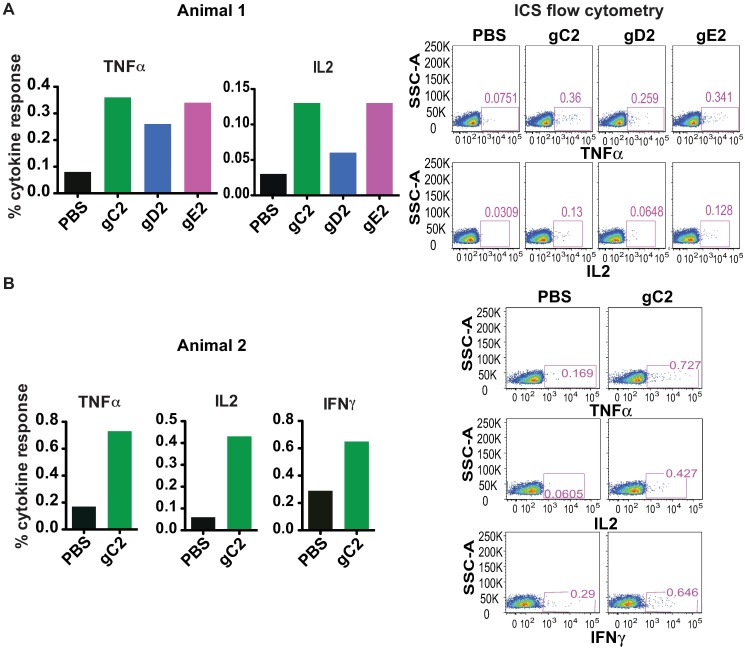
Rhesus CD4+ T cell responses to the trivalent vaccine.(A-B) PBMCs after the booster dose were stimulated in vitro with media, gC2, gD2 or gE2 subunit antigens. Results of each animal are shown separately. The intracellular cytokine staining (ICS) flow cytometry figures are shown to the right of each bar graph.